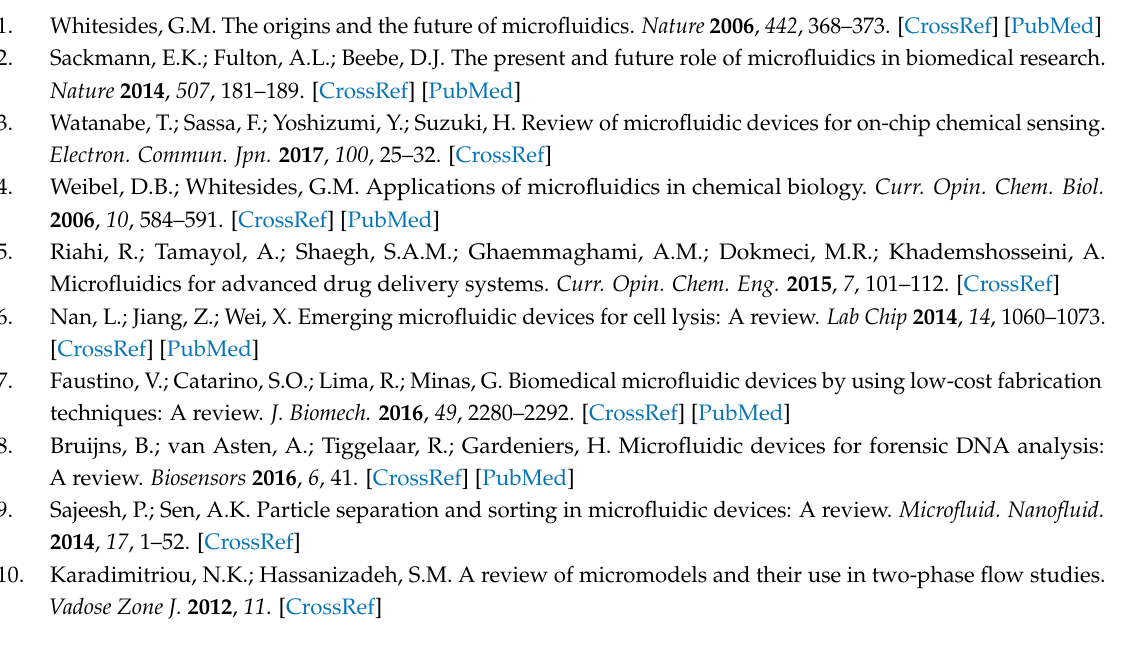
Table S1: Generation of narrow grooves on Borofloat ® 33 glass using PRF = 20 kHz. This dataset was used to plot graphs in Figure 5. Table S2: Generation of narrow grooves on Borofloat ® 33 glass using PRF = 10 kHz. Data not presented in the article. Table S3: Generation of 1 mm × 1 mm areas on Borofloat ® 33 glass. This dataset was used to plot graphs in Figure